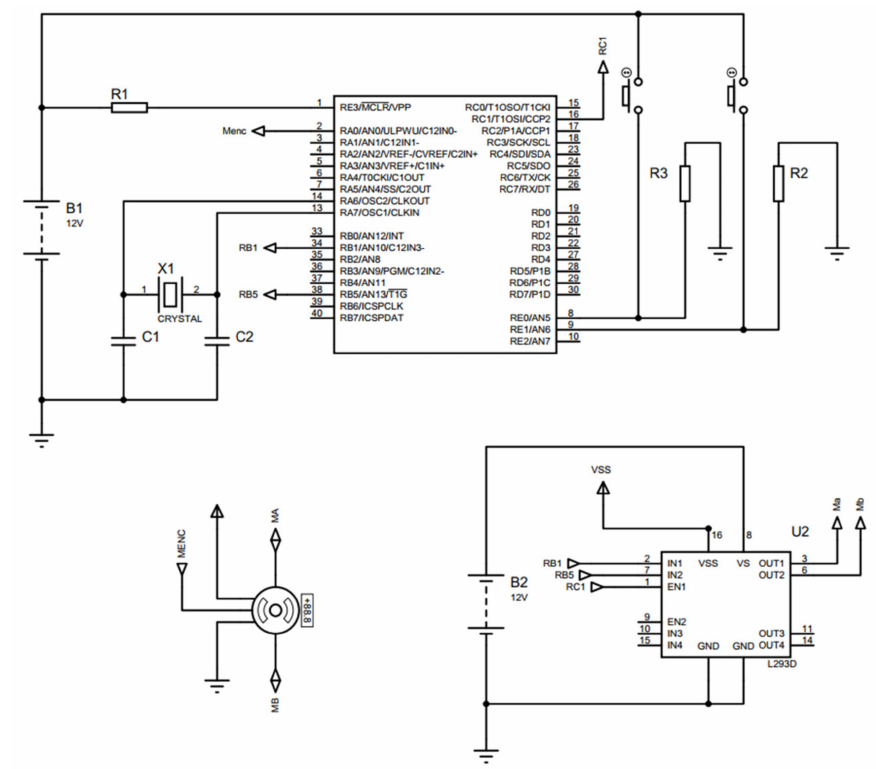
Figure 12. Control